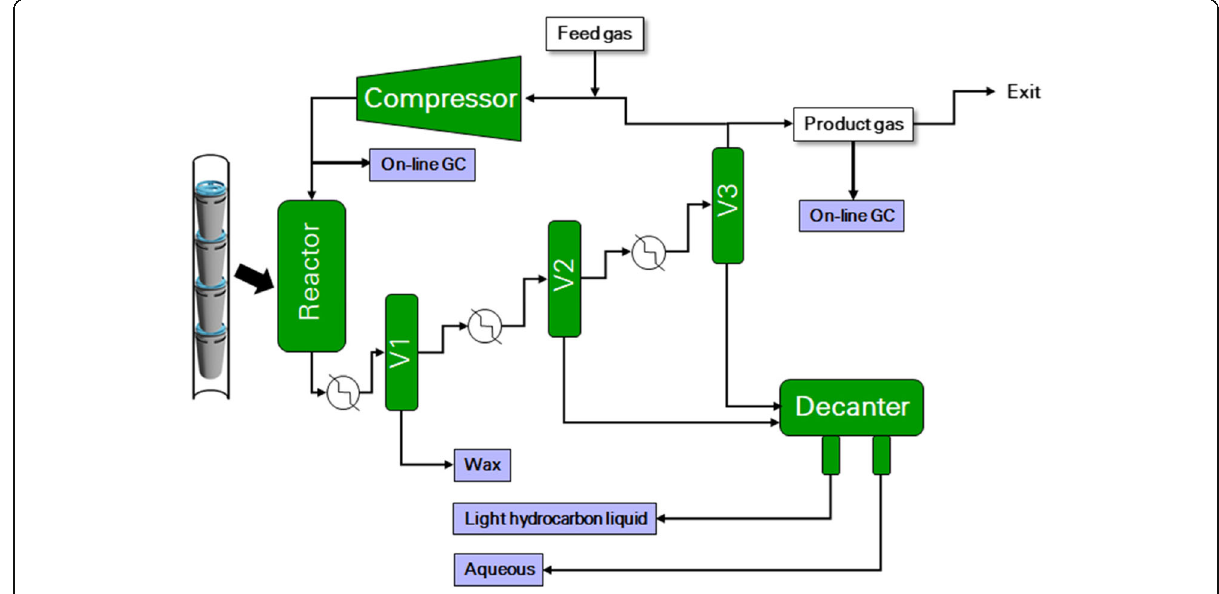
Fig. 2 Schematic of gas phase pilot